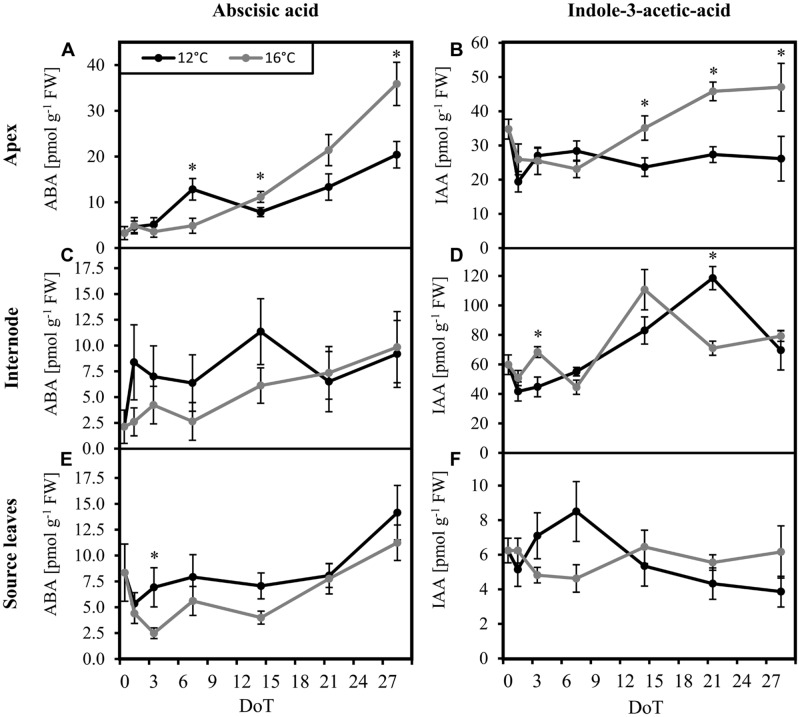
Abscisic acid and indole-3-acetic-acid levels. Impact of sub-optimal temperature (black: 12°C, gray: 16°C) on phytohormone levels. (A) apex, abscisic acid (ABA); (B) apex, indole-3-acetic-acid (IAA); (C) internode, ABA; (D) internode, IAA; (E) source leaves, ABA; (F) source leaves, IAA. (DoT = days after differentiation of temperature; n = 10; data are means ± SE; asterisks indicate significant differences between temperature treatments for a given sampling time, P ≤ 0.05).